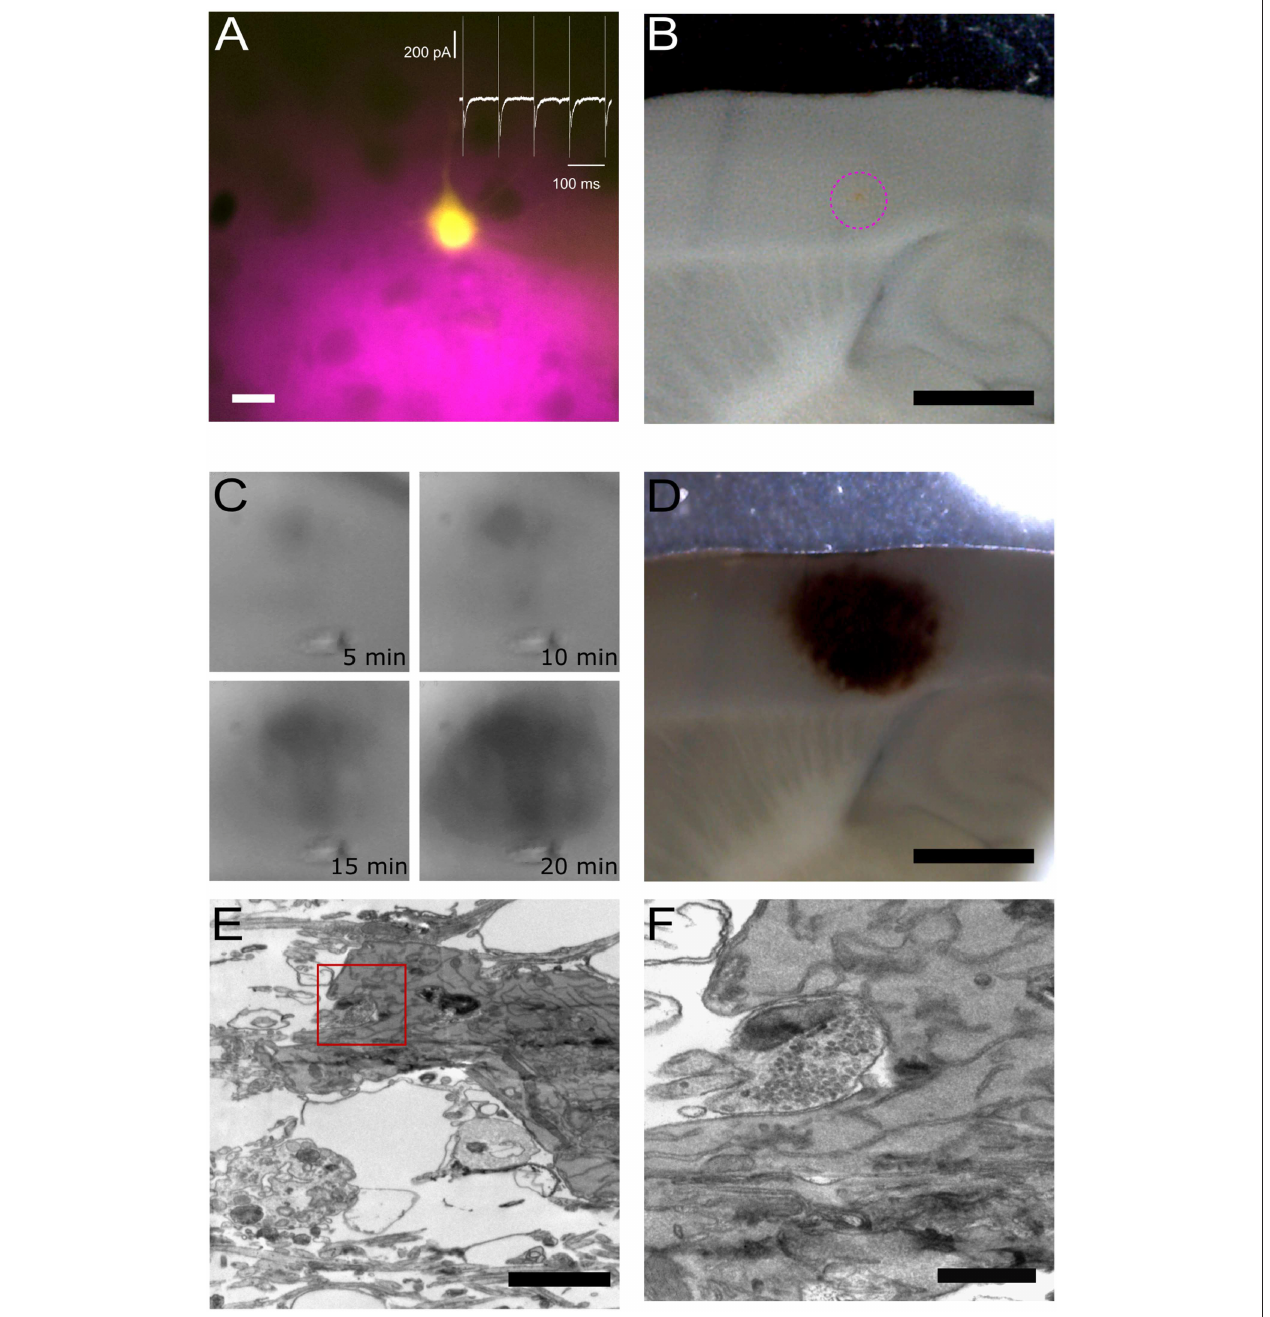
FIGURE 3 | Pre- and post-synaptic photoconversion anticipated results. (A) Pyramidal neuron loaded with Lucifer Yellow with region of pressure-applied FM dye highlighted in magenta. Insert: whole-cell voltage clamp recording from loaded cell. Scale bar: 20 µ m. (B) Acute slice following fixation, with FM dye region clearly visible (magenta dashed circle). Scale bar: 1 mm. (C) Development of the photoconversion product monitored at 5 min intervals. (D) Photoconverted region extending across FM dye region and Lucifer Yellow-loaded neuron. Scale bar: 1 mm. (E) Electron micrograph of Lucifer Yellow-loaded neuron. Scale bar: 20 µ m. (F) Higher magnification electron micrograph of the same spine as (E) , with FM-loaded vesicles observed in the presynaptic terminal. Scale bar: 500 nm.